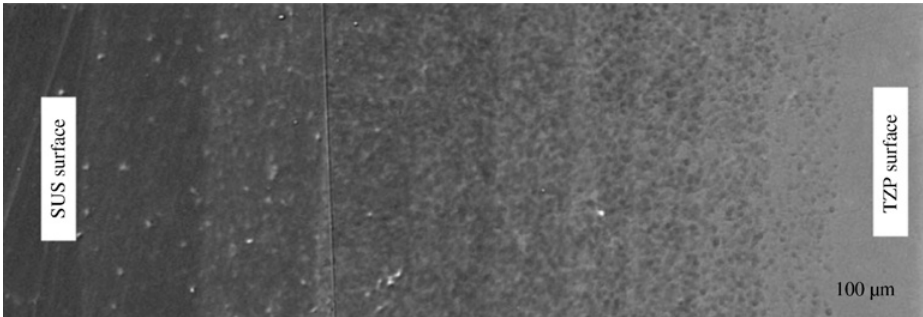
Figure 4: Microstructure of SUS-TZP FGM having 11 layers prepared in alumina mold